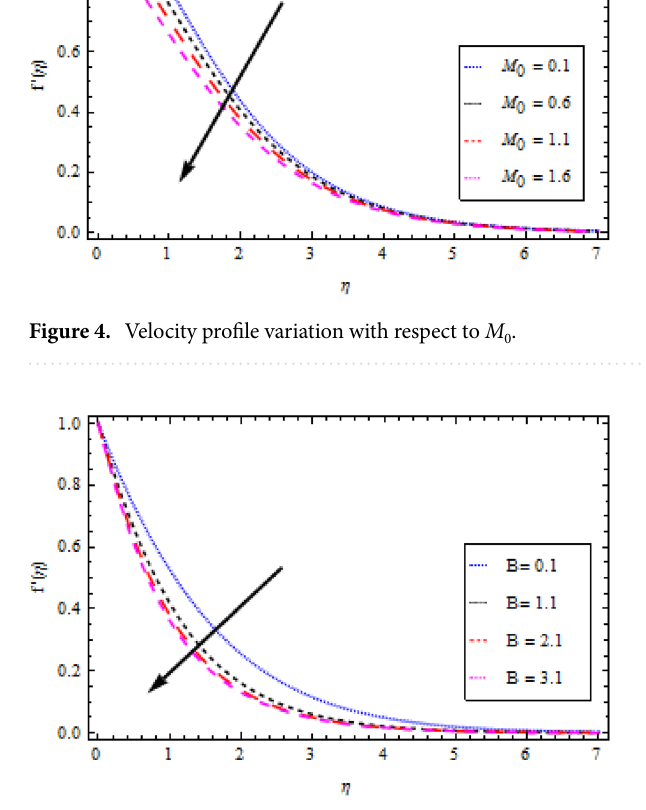
Figure 5. Velocity profile variation with respect to B.